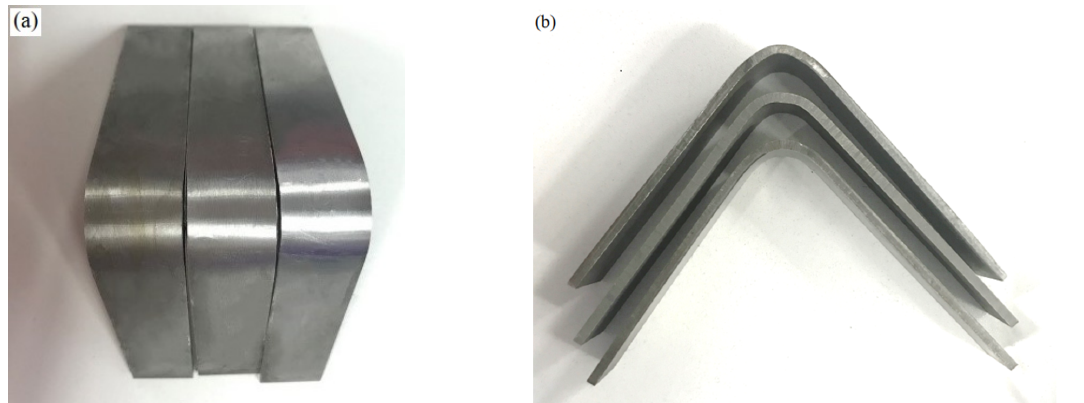
Figure 7. Surface situation of cold bending samples of the joint. ( a ) surface; ( b ) side.